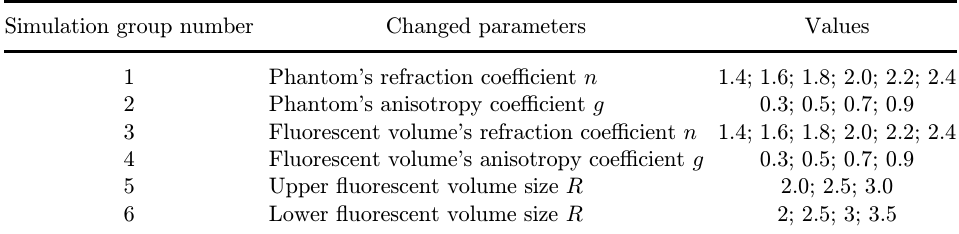
Table 4. Changed parameters of the experiment.